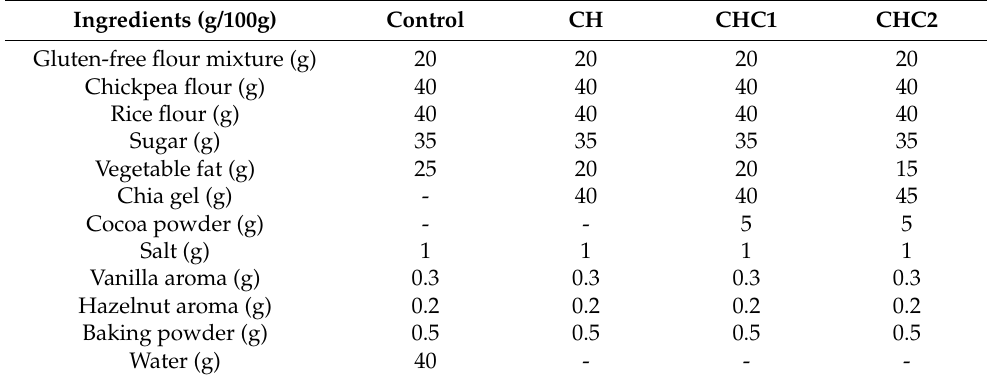
Table 5. Formulation of